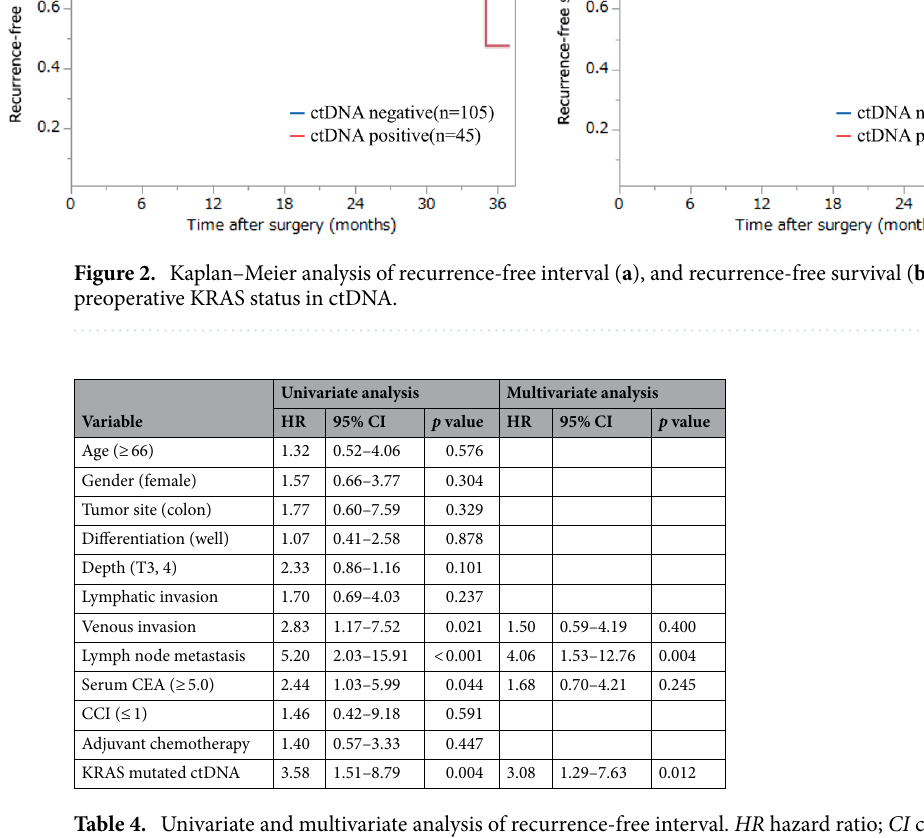
Table 4. Univariate and multivariate analysis of recurrence-free interval. HR hazard ratio; CI confidence interval; Well well differentiated adenocarcinoma; CEA carcinoembryonic antigen; CCI Charlson comorbidity index.